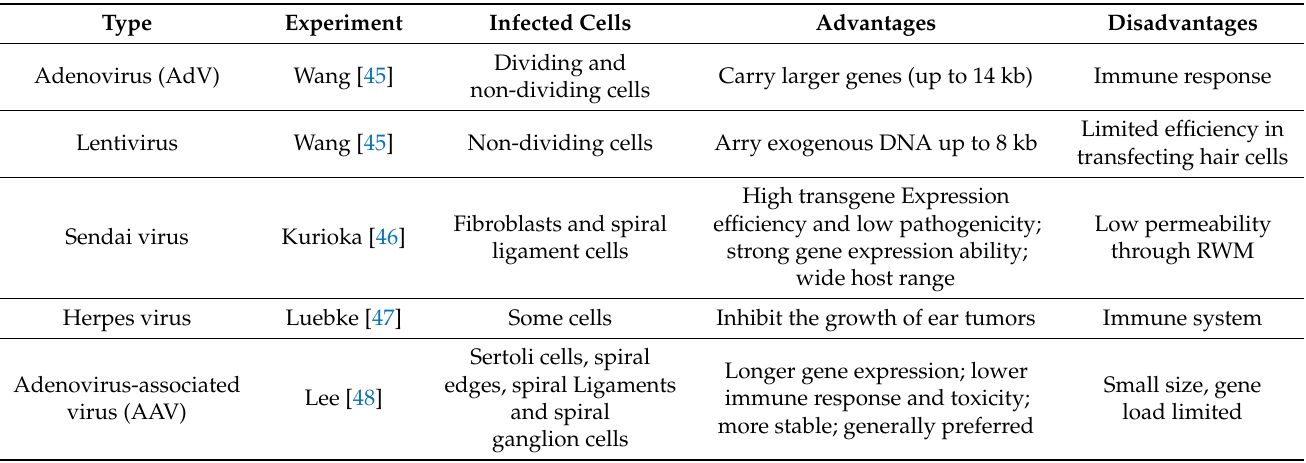
Table 5. Common methods of inner ear gene therapy.